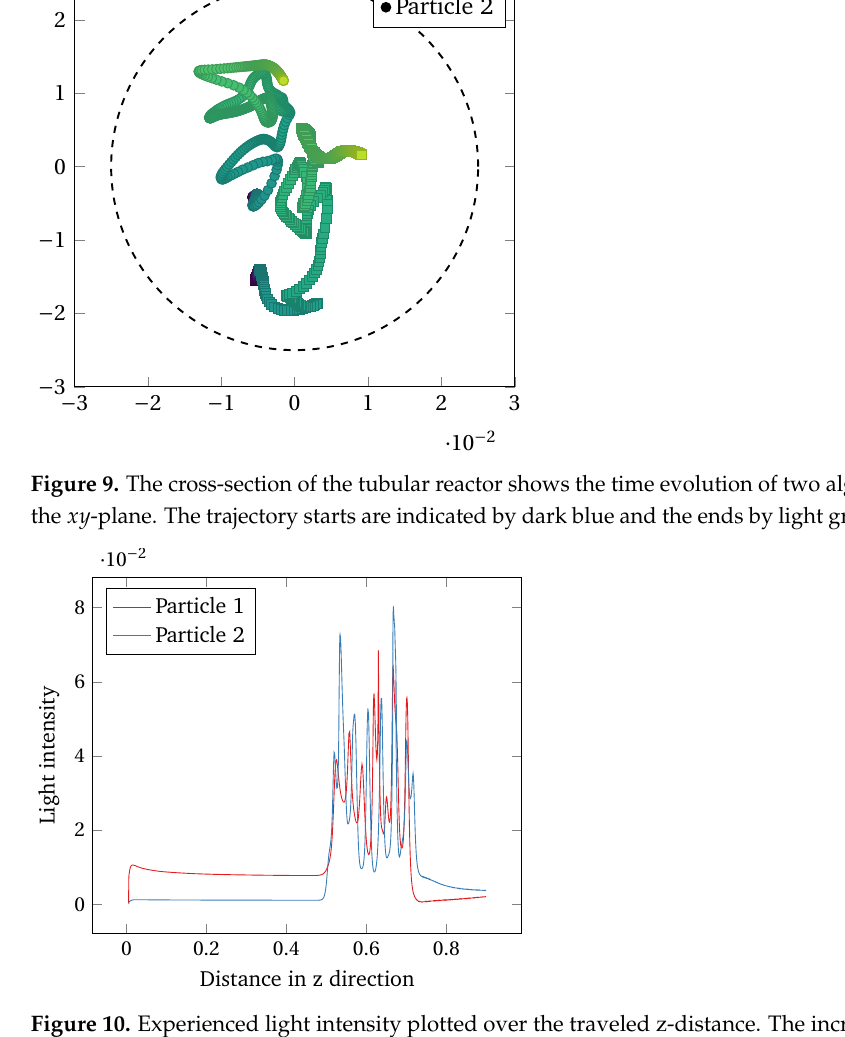
Figure 10. Experienced light intensity plotted over the traveled z-distance. The increase of subjected light intensity at the z-position 0.5m is due to the sponge structure. Before and after the sponge structure, the subjected light is